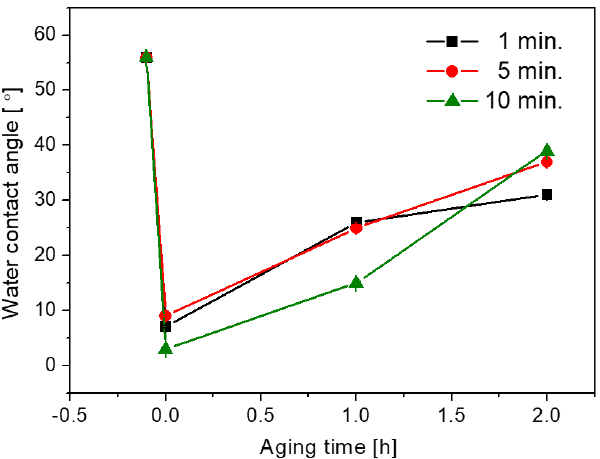
Figure 4. Ion energy distributions for extractor voltages of 0, 100, 200, and 300 V under a constant sputter voltage of − 550 V.